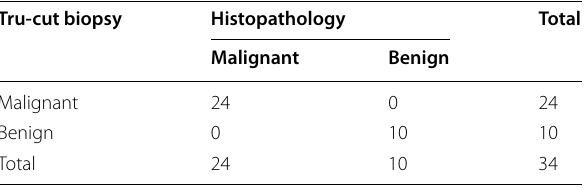
Table 3 Cross‑tabulation between results of Tru‑cut biopsy and final histopathology